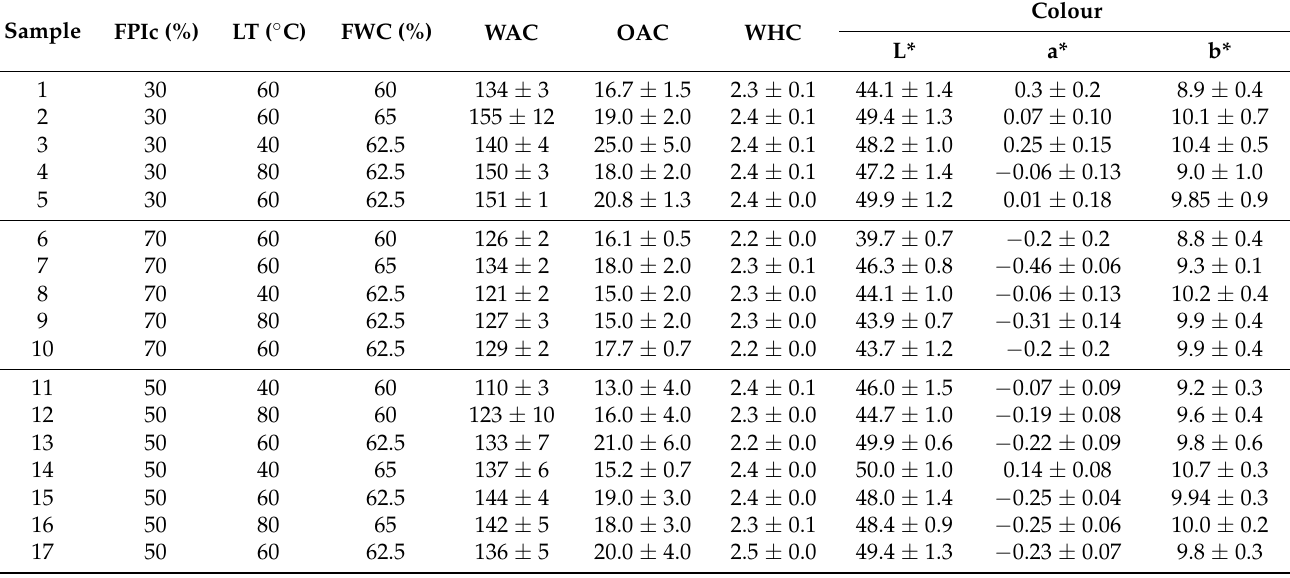
Table A3. Water absorption capacity (WAC), oil absorption capacity (OAC), water hydration capacity (WHC), and colour parameters L* (0 = black, 100 = white), a* ( − = green, + = red), and b* ( − = blue, + = yellow) of the samples with different independent variables, including faba bean protein